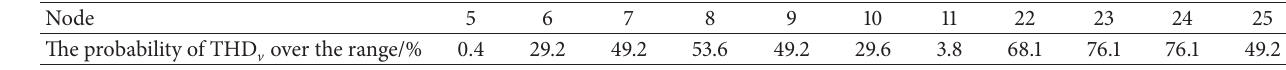
Table 7: The detailed information of THD V over the range.